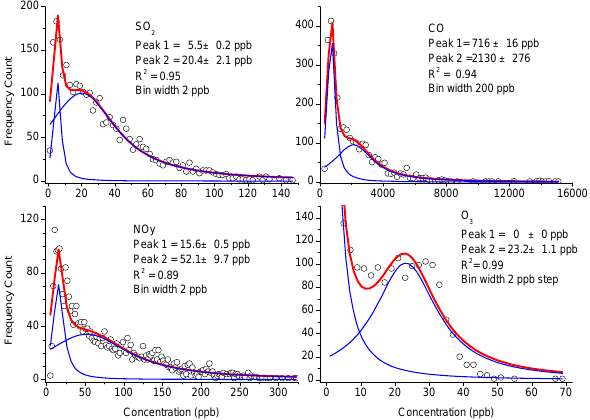
Fig. 4 The frequency distributions of hourly average concentrations of NO y , SO 2 , CO, and O 3 . Lorentz curve fitting was applied to the frequency distributions. The large concentration differences between the first and second fitted curves suggest that the pollutants concentrations were controlled by two very different atmospheric conditions.